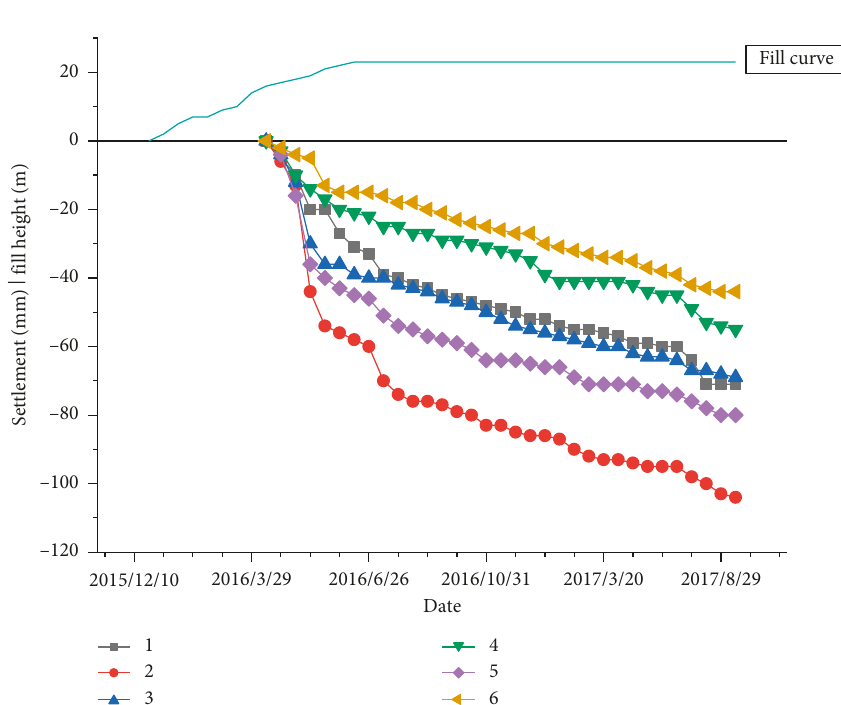
Figure 7: The relation curve between settlement and time in subgrade monitoring